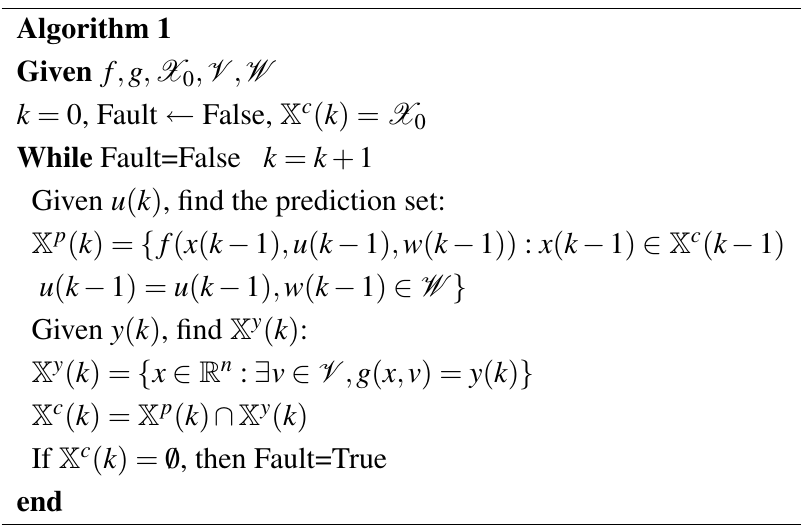
Table 4. State space set-membership fault